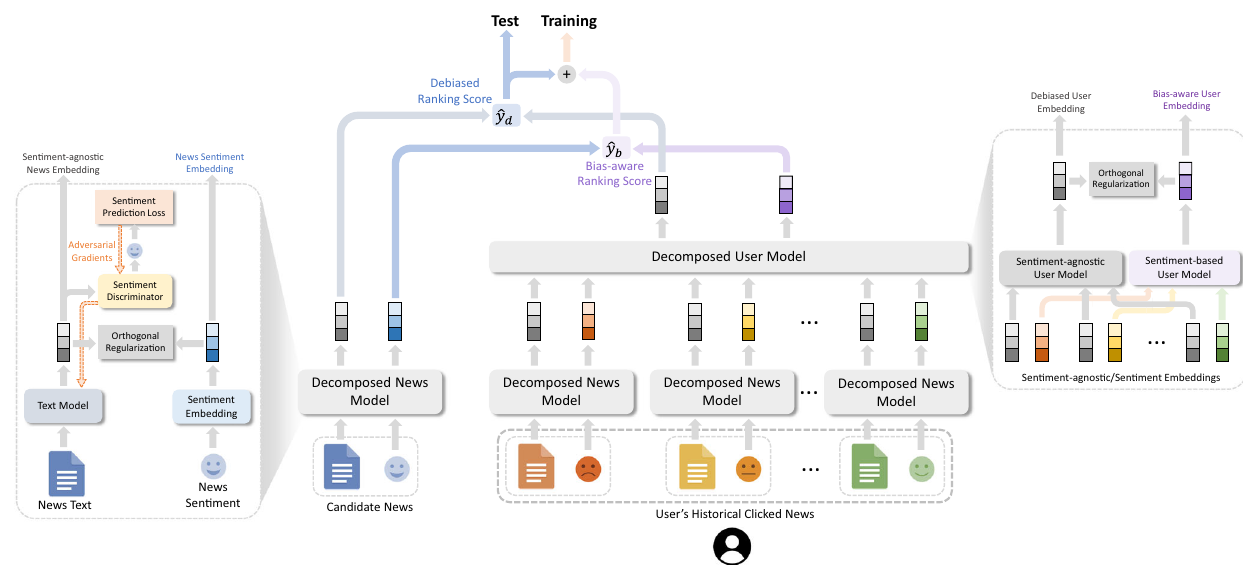
Fig. 2 The framework of our sentiment-debiasing approach. It removes the sentiment manipulation of personalized news recommendations by learning sentiment-agnostic news and user representations via decomposed adversarial